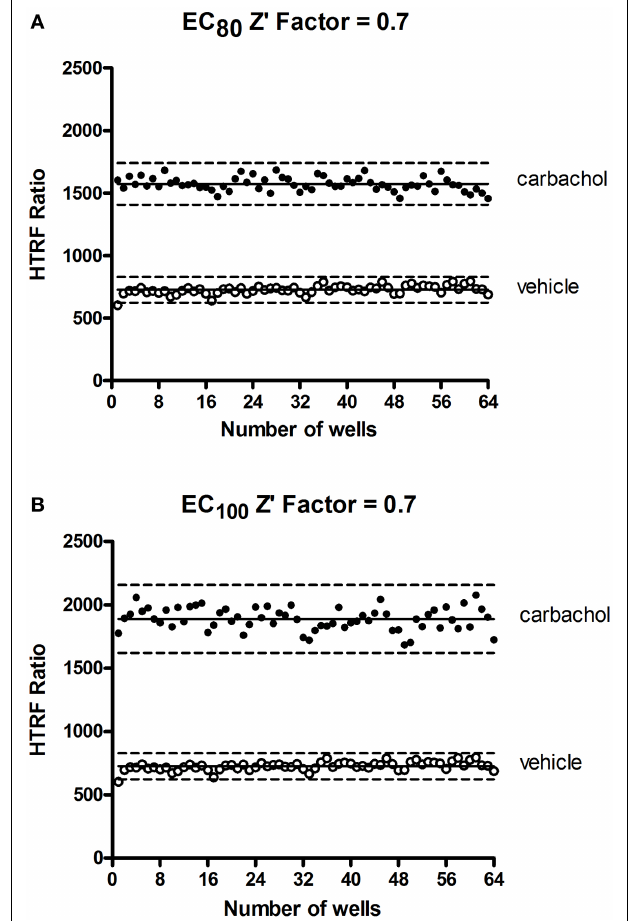
FIGURE 7 | Z (cid:48) -factor measurements for the Phospho-ERK assay . CHO cells stably expressing the muscarinic receptor 1 (M1) were used for the determination of Z (cid:48) -factor for the Phospho-ERK1/2 assay using the Phospho-ERK assay one-plate protocol. Cells were stimulated or not with 1.33 µ M (EC 80 ) (A) or 4 µ M (EC 100 ) (B) of carbachol for 15min and HTRF signals were measured as described in Section “Materials and Methods.” Solid lines show the means of the positive control (carbachol) and negative control (vehicle). Broken lines display three standard deviations from the mean of each data set [Adapted from the CisBio Bioassays website (see text footnote 2) with